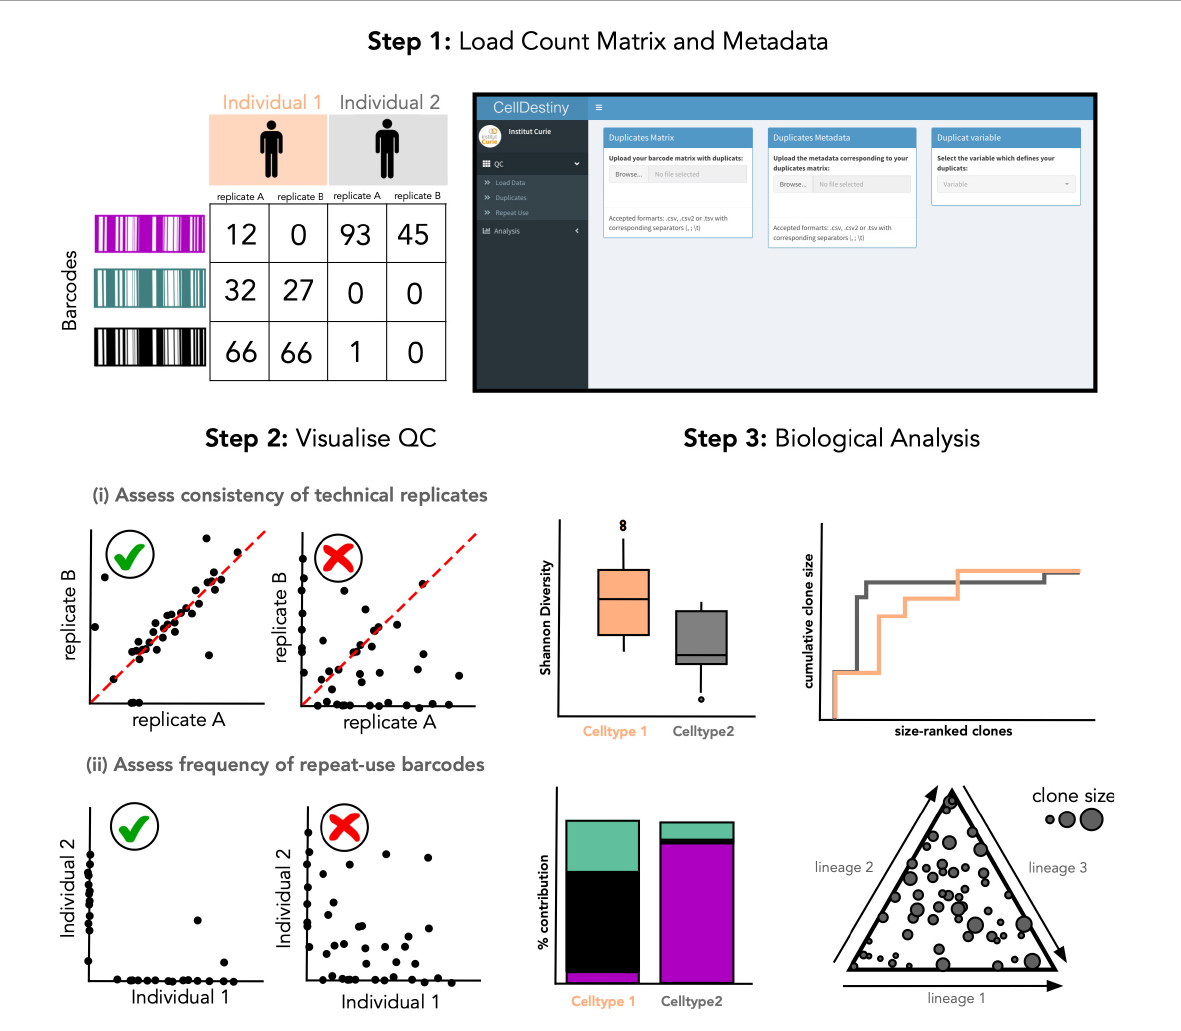
FIGURE2 Overview of the CellDestiny analysis toolkit. (Step 1) A count matrix containing technical replicates for each sample after data quality control and normalization steps, for example using the genBaRcode package, can be uploaded along with associated metadata detailing the variables used for the analysis such as organ, time point, individual etc. (Step 2) The quality of the data can be visualized to assess the correlation between duplicates and also the frequency of repeat-used barcodes. These steps will help the user to assess the impact of technical artifacts on the biological interpretation of the data. (Step 3) The data summed or averaged over replicates can then be uploaded and visualized through a set of different graphs to assess clonal diversity, clone-size distribution and fate outcomes. Importantly, these graphs offer several customization options such as grouping data across individuals, cell types and